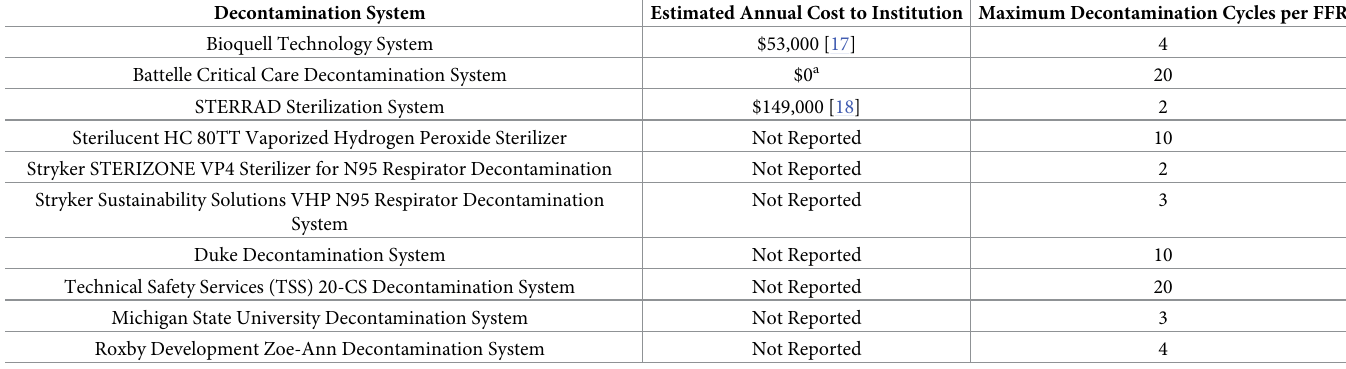
Table 1. Value Comparison of H 2 O 2 decontamination systems with EUAs. Decontamination